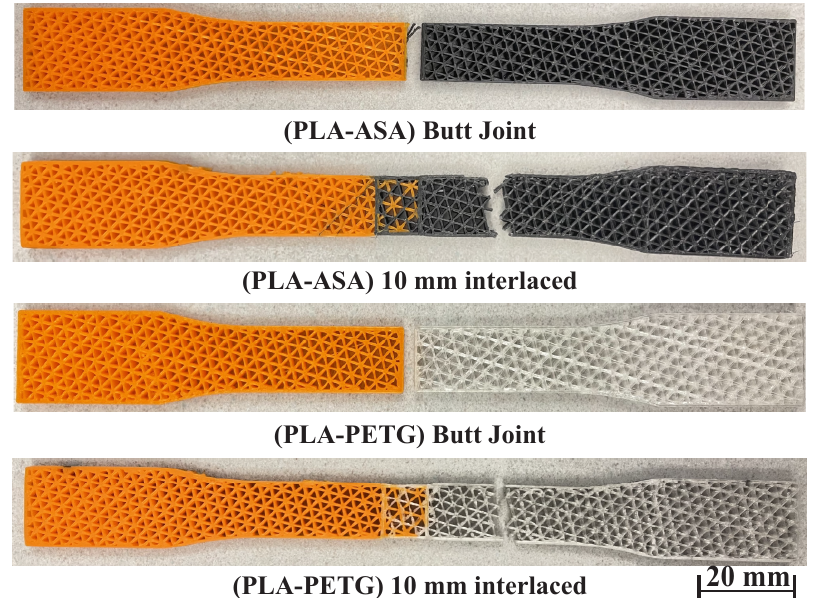
Figure 15. Fractured samples of butt joints and interlaced infills for the material combinations: PLA-ASA and